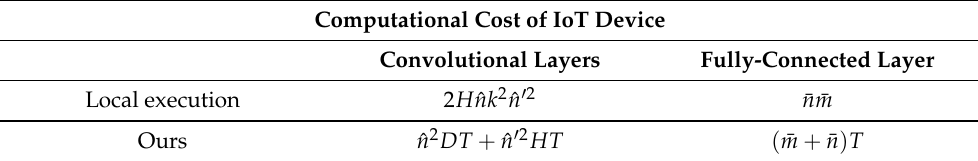
Table 3. The comparison of computational cost of IoT device between local execution and our